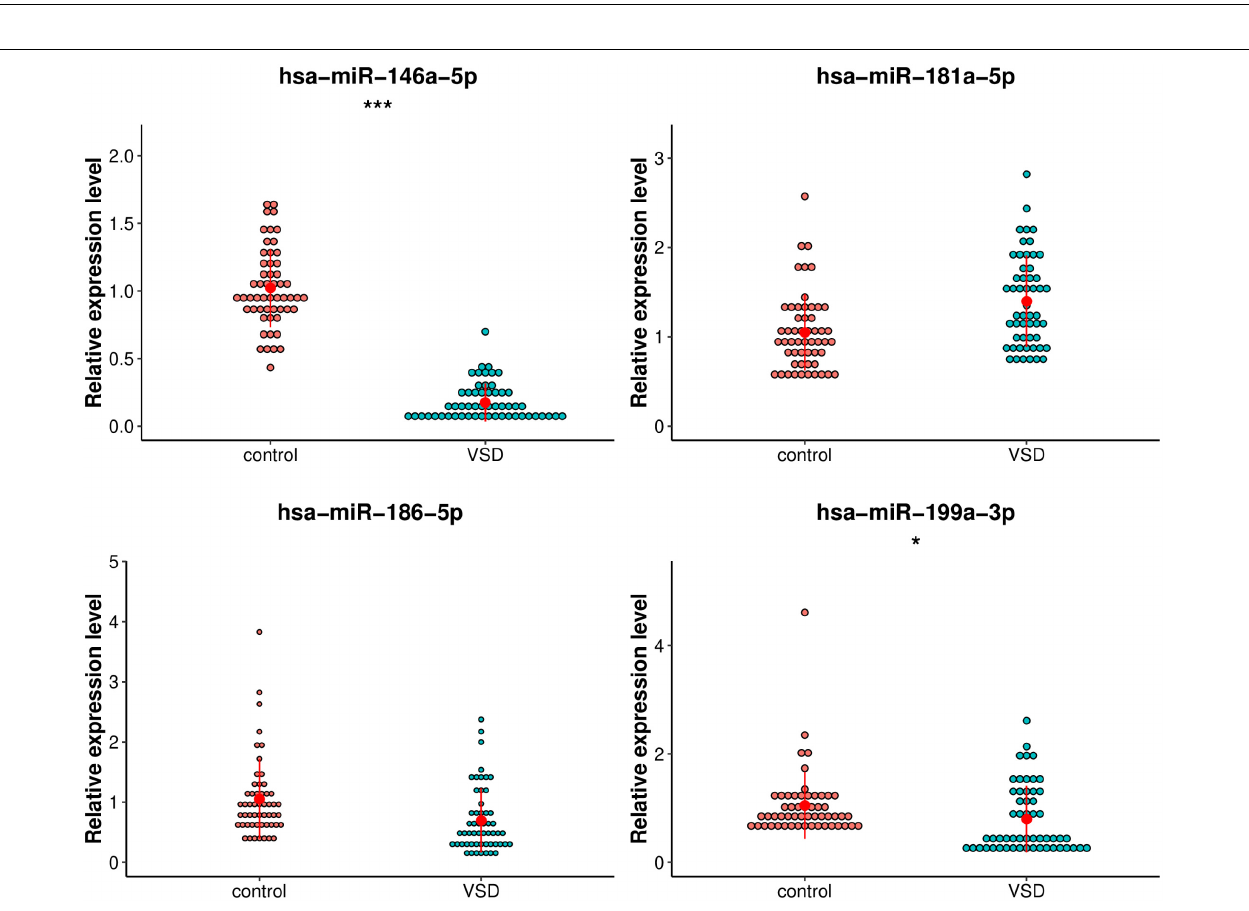
FIGURE 3 | Bioinformatics analysis based on the sequencing results. (A) Gene Ontology enrichment results of cellular components, biological processes, and molecular functions. The enrichment score [–log10 ( p -value)] of each term is shown on the horizontal axis and the term name on the vertical axis. (B) Kyoto Encyclopedia of Genes and Genomes enrichment results are displayed through a bubble chart. The horizontal axis shows the rich factor of each pathway. The number of genes involved in each pathway is indicated through the size of the bubbles while the color represents each p -value.